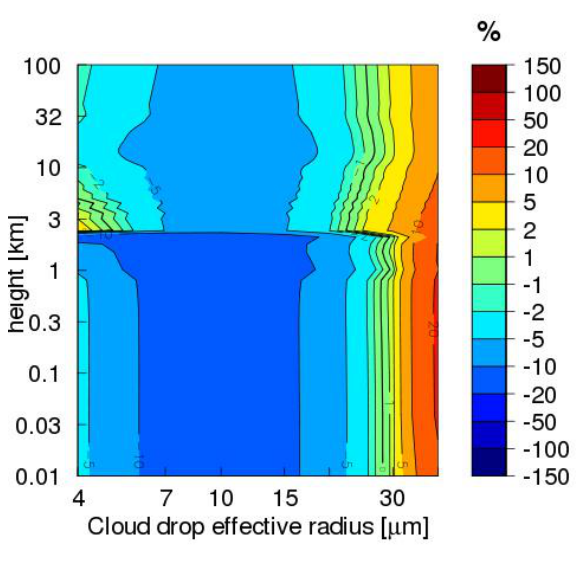
Figure 17. As for Fig. 16 but for IFS-Slingo vs. HS-DISORT.